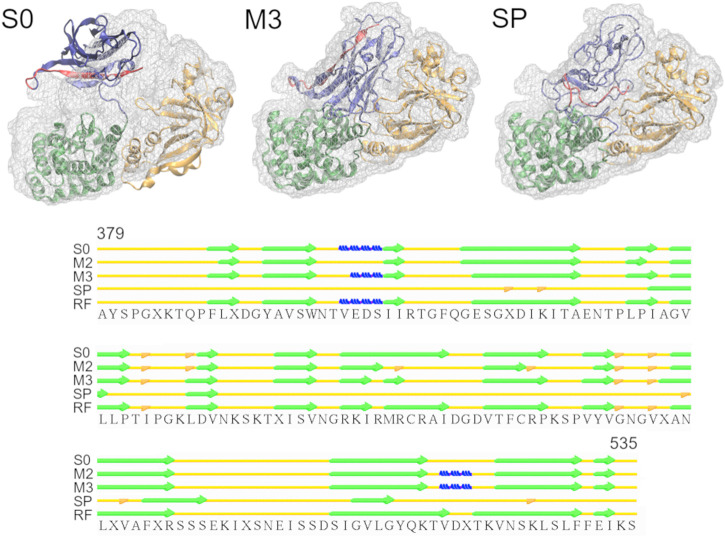
Simulations of Diphtheria Toxin. Initial structure (S0), the highest CC models obtained using the multi-scale protocol (M3) and the simple protocol (SP) are superimposed with the target density map. The R domain is shown in blue with residues 520-535 highlighted in red. The graph below depicts the secondary structure elements in the R domain of the structures from M3, SP and the reference structure (RF), as assigned by the Stride web server. β-strands, 3-10 helices and isolated β-bridges are shown in green, blue and orange, respectively.